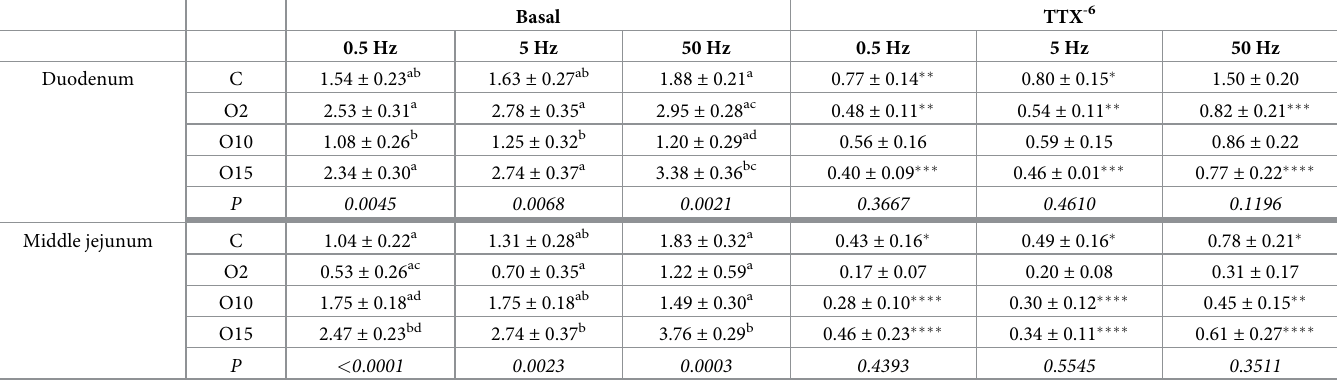
Table 3. The effect of enteral obestatin administration on the electrical field stimulation (EFS)—Evoked amplitude of contraction [mm] in the presence or absence of Tetrodotoxin (TTX (10 − 6 M)) in duodenal and middle jejunum strips from piglets.